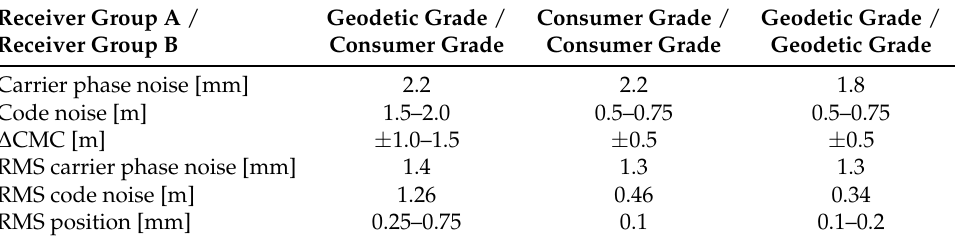
Table 3. Summarized key parameters obtained by the benchmark